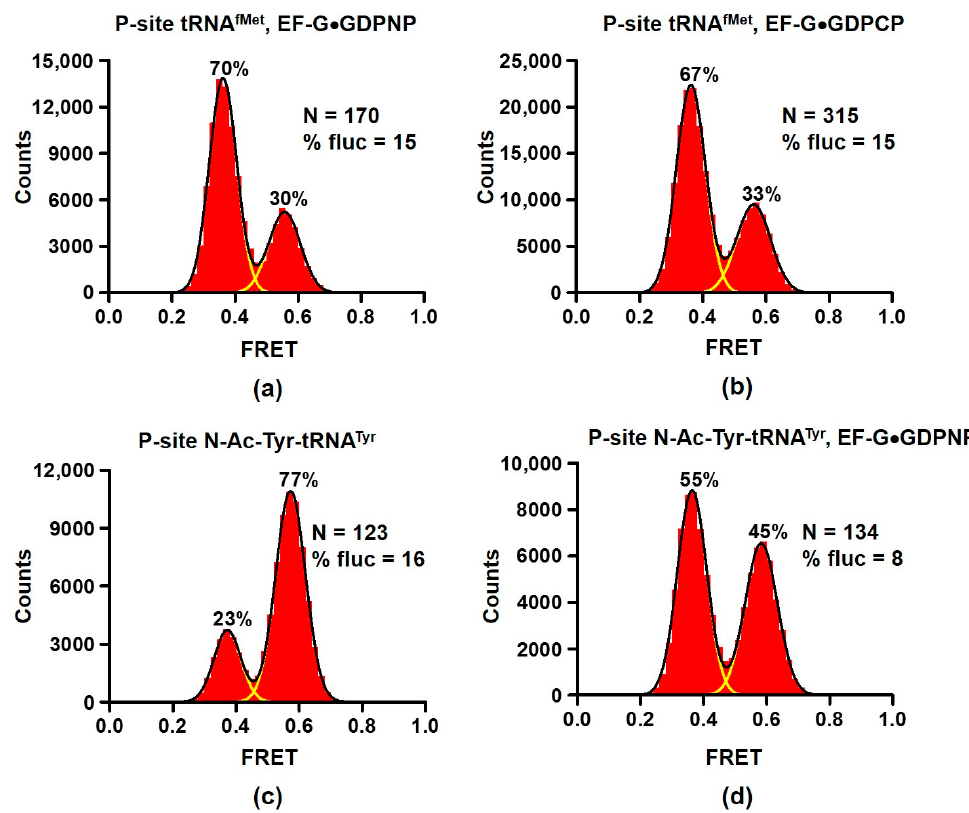
Figure 2. EF-G stabilizes the rotated conformation of the ribosome. Histograms show FRET distri- bution in S6-Cy5/L9-Cy3 ribosomes. Ribosomes bound with P-site deacylated tRNA fMet ( a , b ) were incubated with either EF-G • GDPNP ( a ) or EF-G • GDPCP ( b ). Ribosomes bound with P-site acylated N-Ac-Tyr-tRNA Tyr ( c , d ) were incubated with EF-G • GDPNP ( d ). N indicates the total number of FRET traces compiled into each histogram. % fluc designates the percentage of traces that show fluctuations. Yellow lines show individual Gaussian fits. Black line indicates the sum of Gaussian fits. The fraction of the ribosomes in the R and NR conformations are shown above the corresponding 0.37 and 0.56 Gaussian peaks.